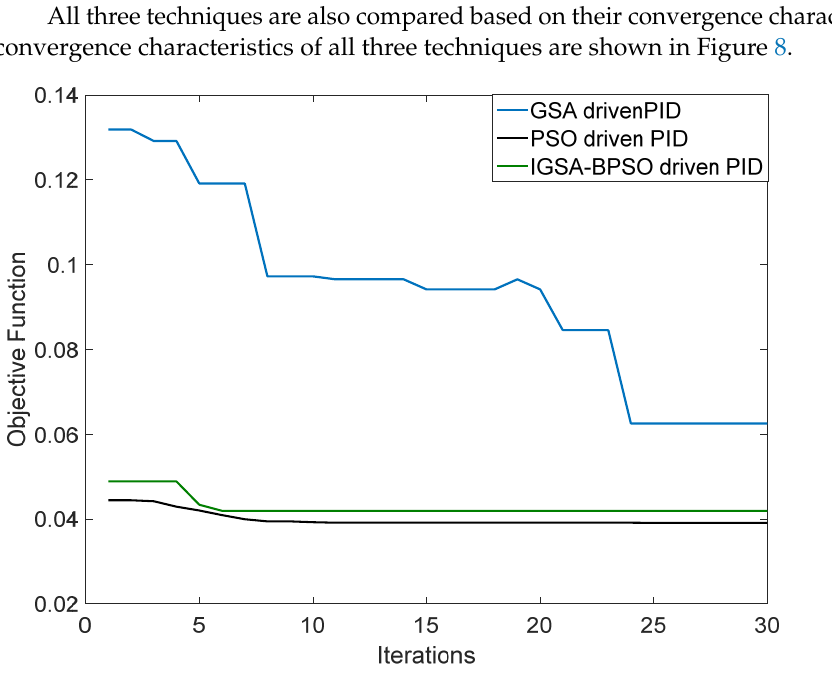
Table 7. PID parameters tuning for hybrid test system and ITAE values: CVT.